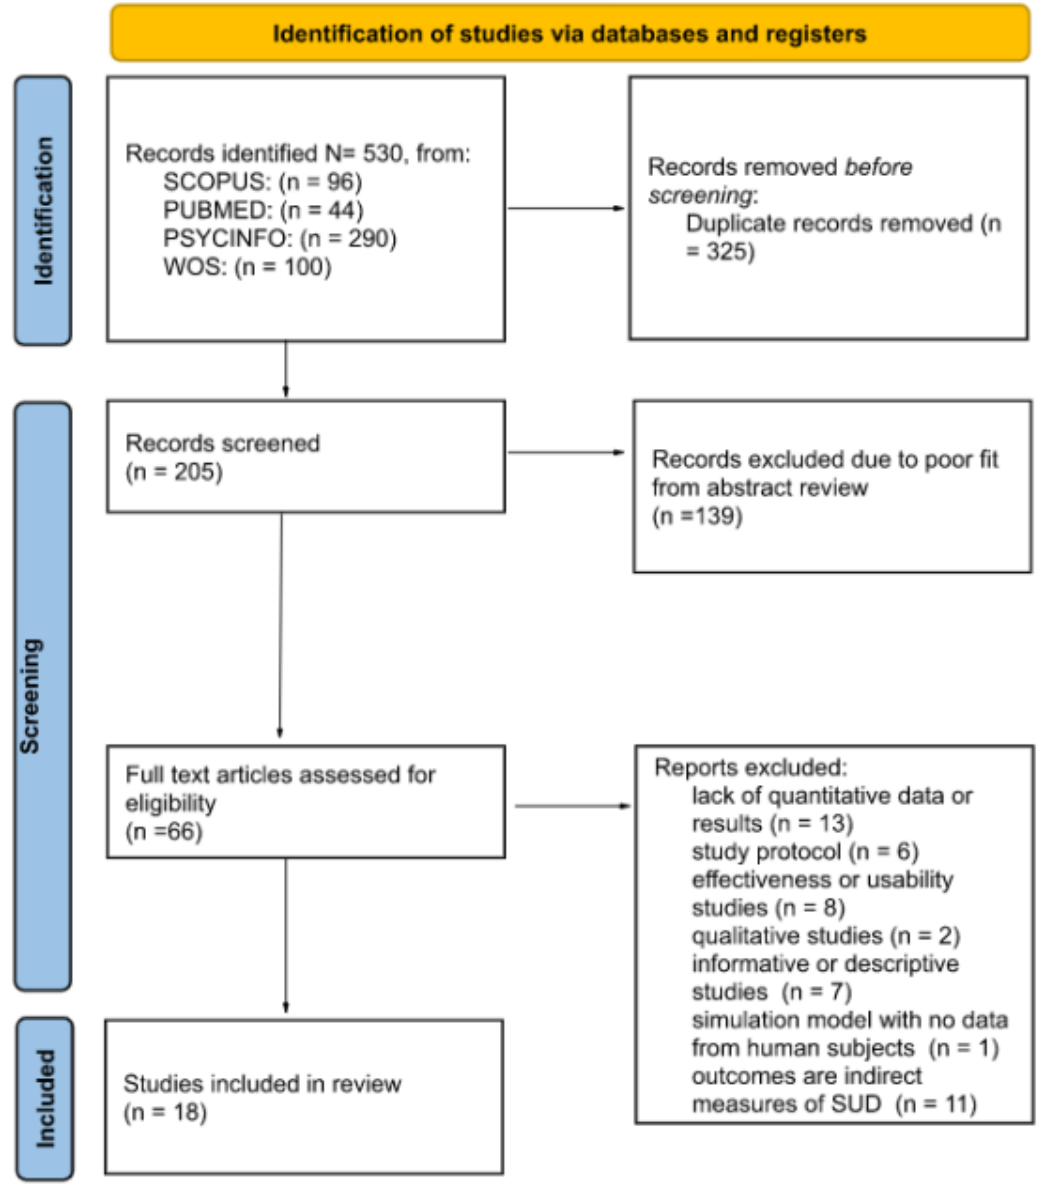
Figure 1. Systematic literature search, screening, and relevance assessment conducted according to PRISMA guidelines.